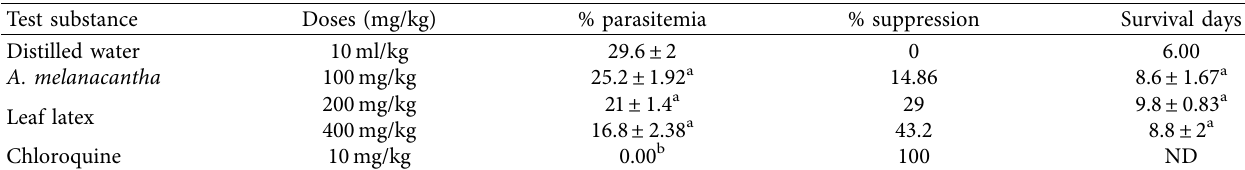
Table 2: Four-day chemosuppression antimalarial activities and effect on survival time of leaf latex of A. melanacantha against Plasmodium berghei infected mice.